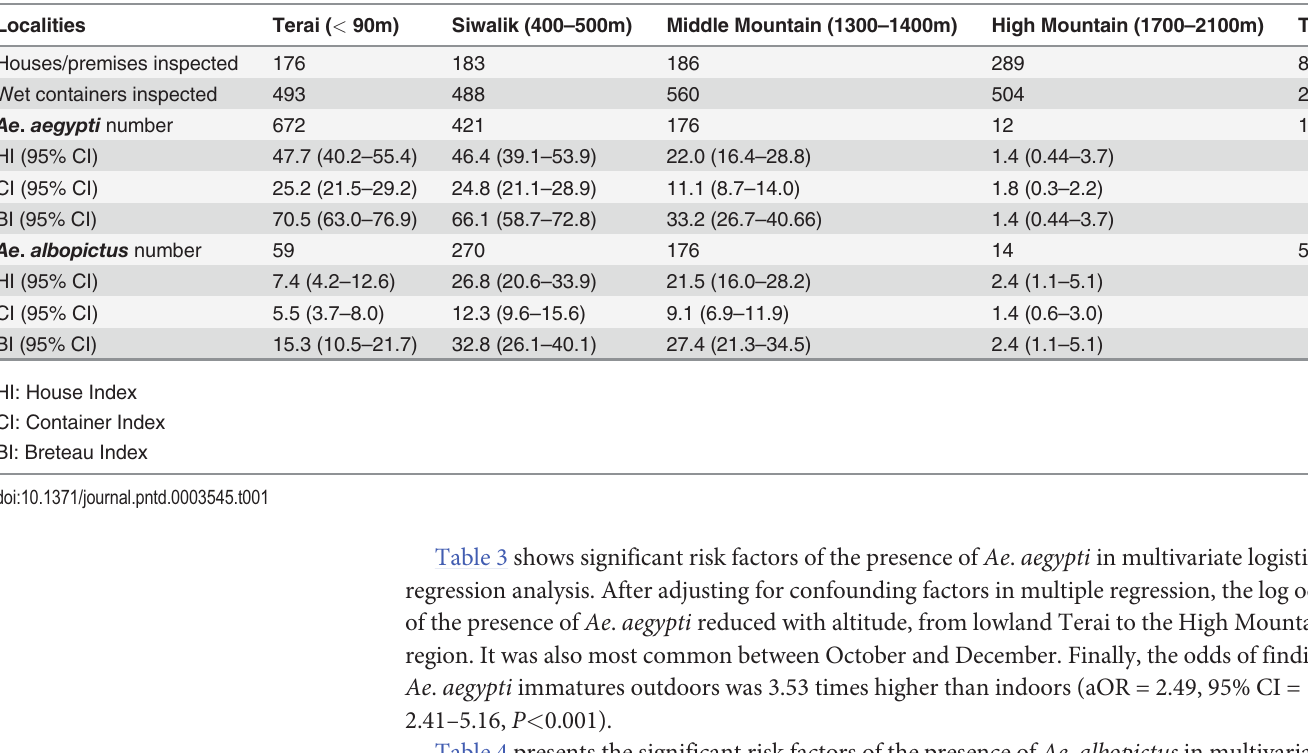
Table 4 presents the significant risk factors of the presence of Ae . albopictus in multivariate logistic regression analysis. Aedes albopictus was most prevalent in regions at intermediate alti- tudes (i.e., Siwalik hills and Middle Mountain region), and was least prevalent in January and